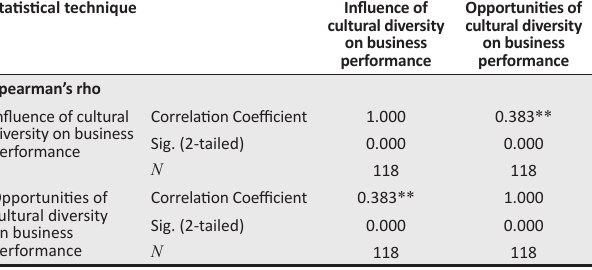
TABLE 3: Spearman’s correlation test on the influence of cultural diversity on business performance. Statistical